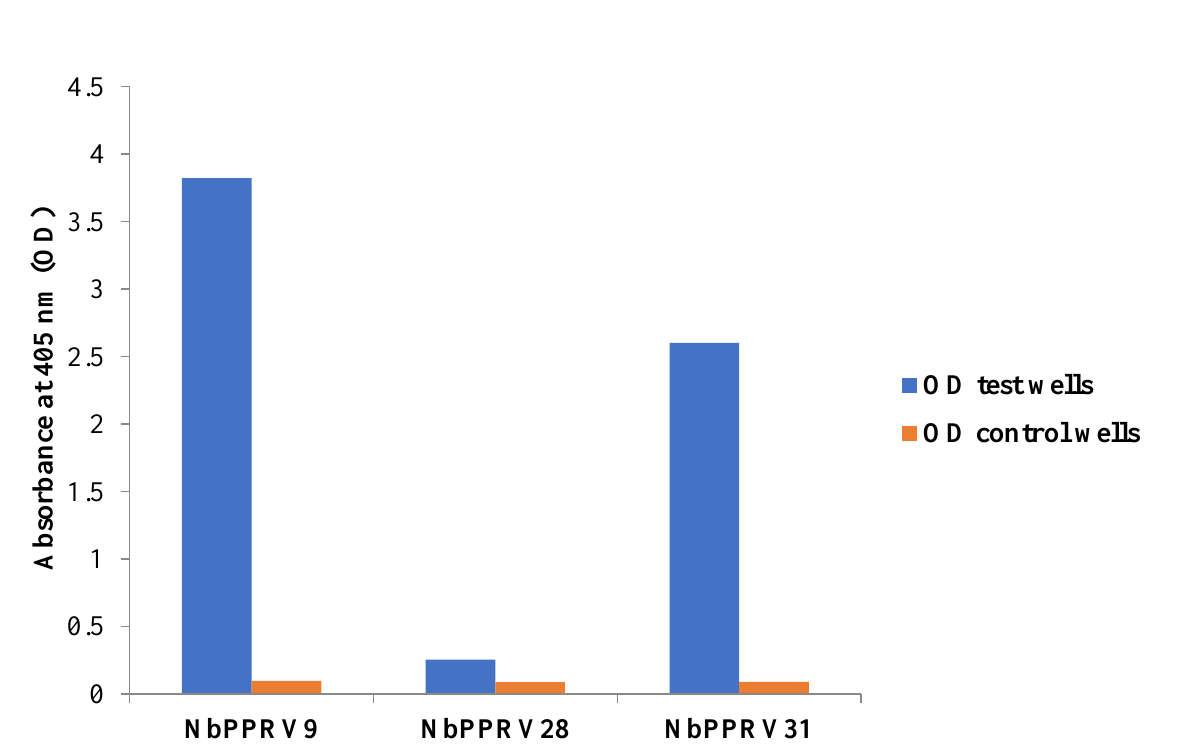
Figure 2. The bar chart represents an optical density of potent nanobodies directed against peste des petits ruminants virus (PPRV) in indirect enzyme-linked immunosorbent assay (ELISA). These nanobodies were rapidly detecting PPRV antigens with distinct signal strength in each nanobody family upon development of ELISA.